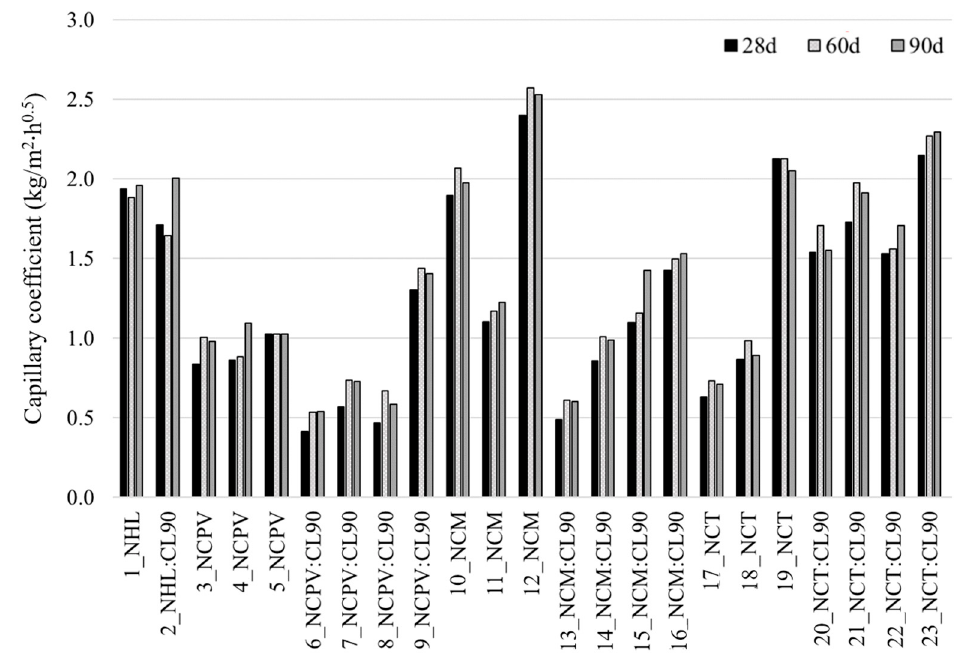
Figure 10. Capillarity water absorption coefficient (C) after 28, 60, and 90